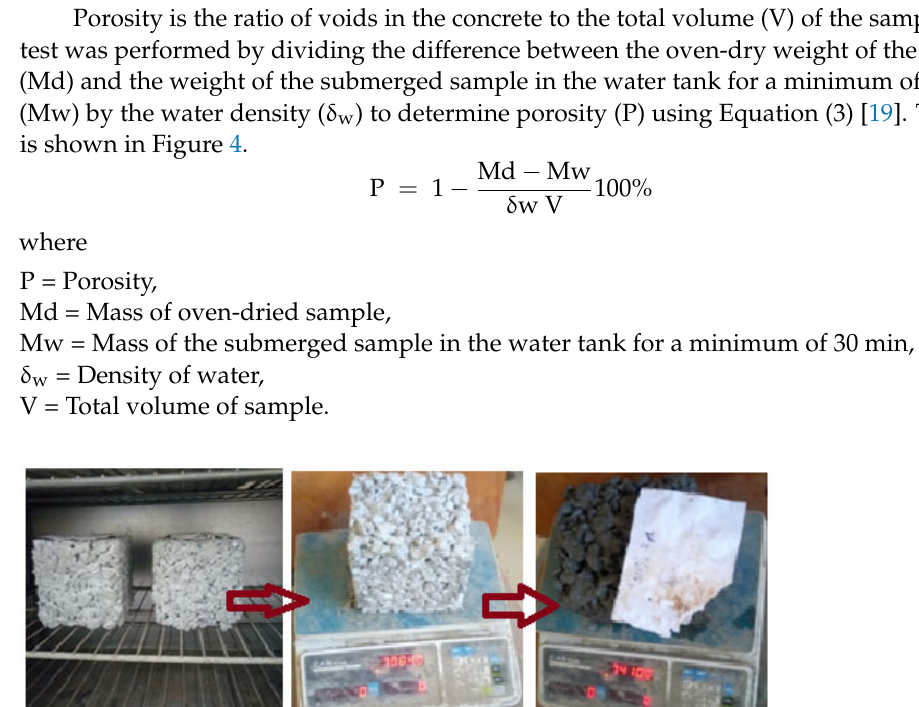
Figure 3. Compressive strength testing.